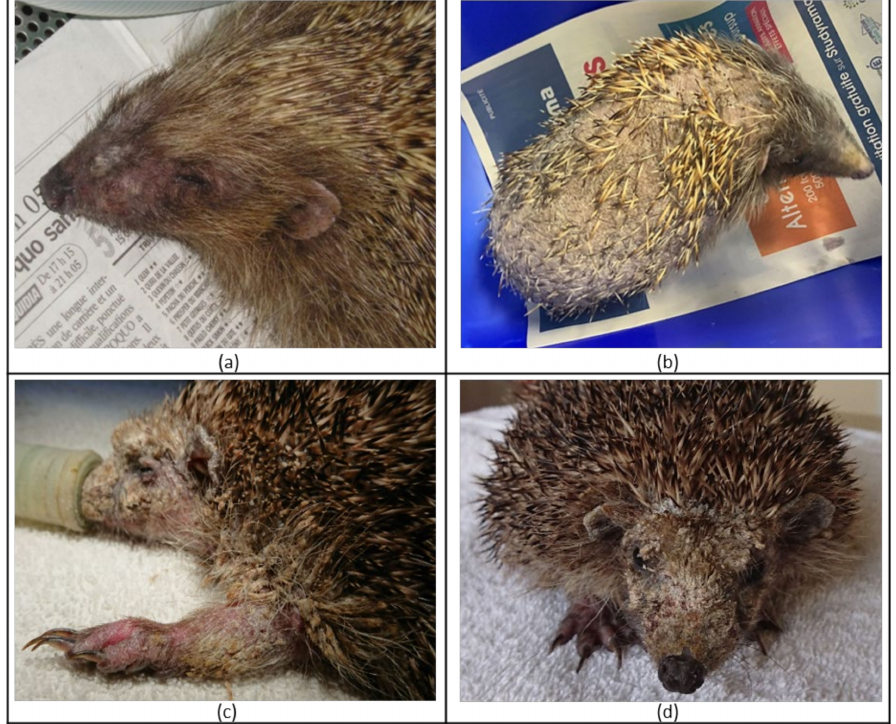
Figure 3. Mild ( a ), moderate ( b ) and severe ( c , d ) skin lesions observed in wild European hedgehogs ( E. europaeus ) during clinical examination on admission to the rescue centre. Lesions are often associated with localised ( a ) or generalised ( c , d ) scaly skin, alopecia (hair loss), spine loss ( b ) and erythema ( c